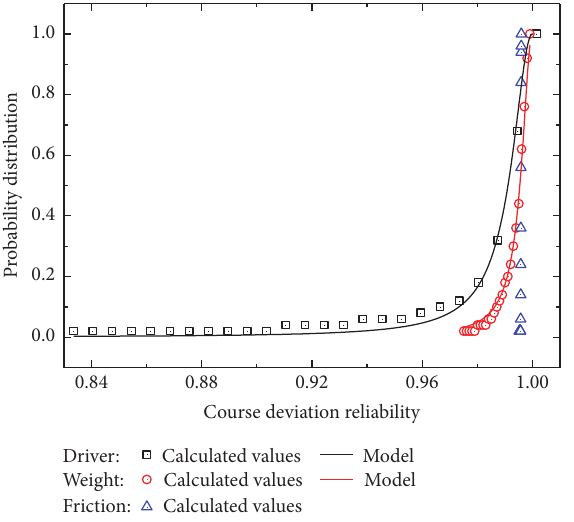
Figure 11: Probability distribution model of reliability. Figure 12: Probability distribution of reliability (combined random